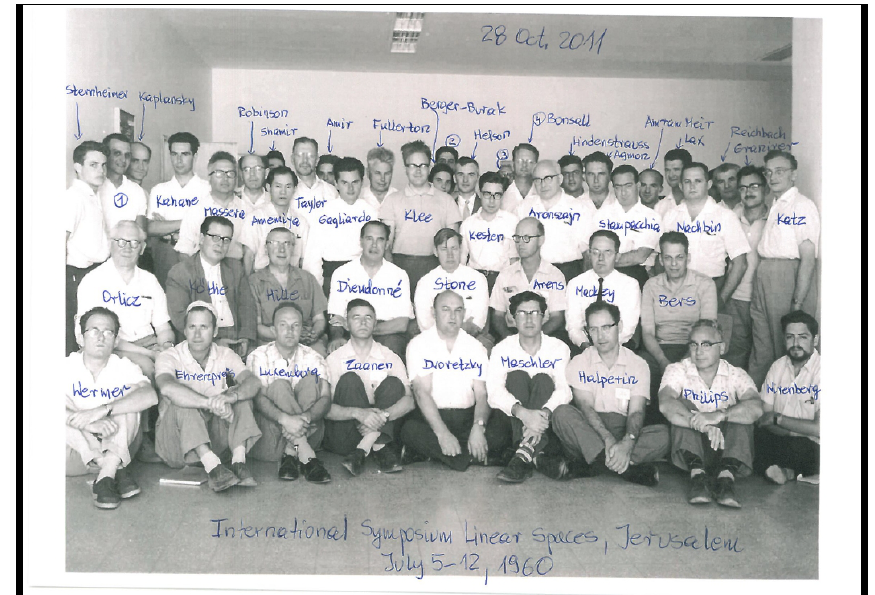
Figure 1. Jerusalem 1960, Linear Spaces